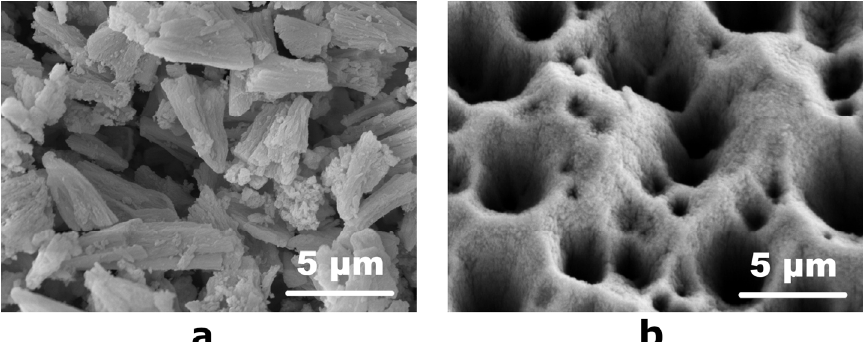
Figure 3. SEM micrographs of ( a ) the separated fine powder (note the conical shape of the particles that has not changed during the ultrasonic treatment) and ( b ) the etched surface after the ultrasonic